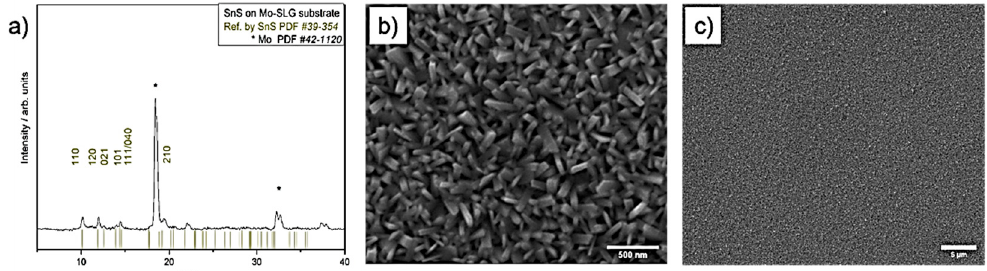
Figure 7. XRD pattern ( a ) of SnS deposited at 350 °C, and SEM top view at different magnifications ( b , c ) of SnS deposited on Mo-SLG at T = 350 °C .